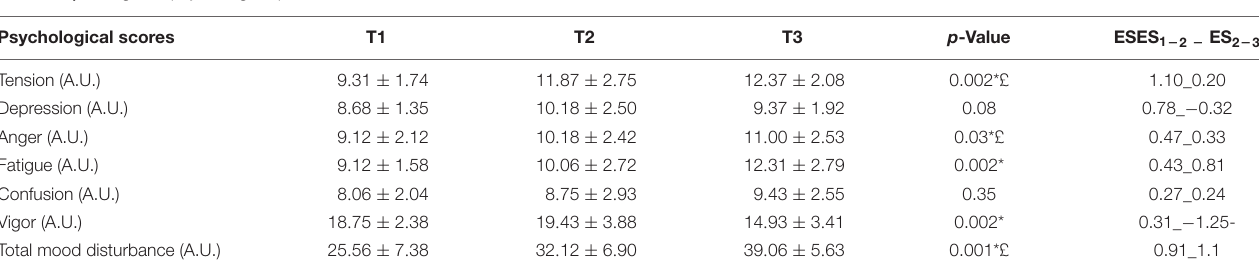
TABLE 7 | Changes in psychological parameters.